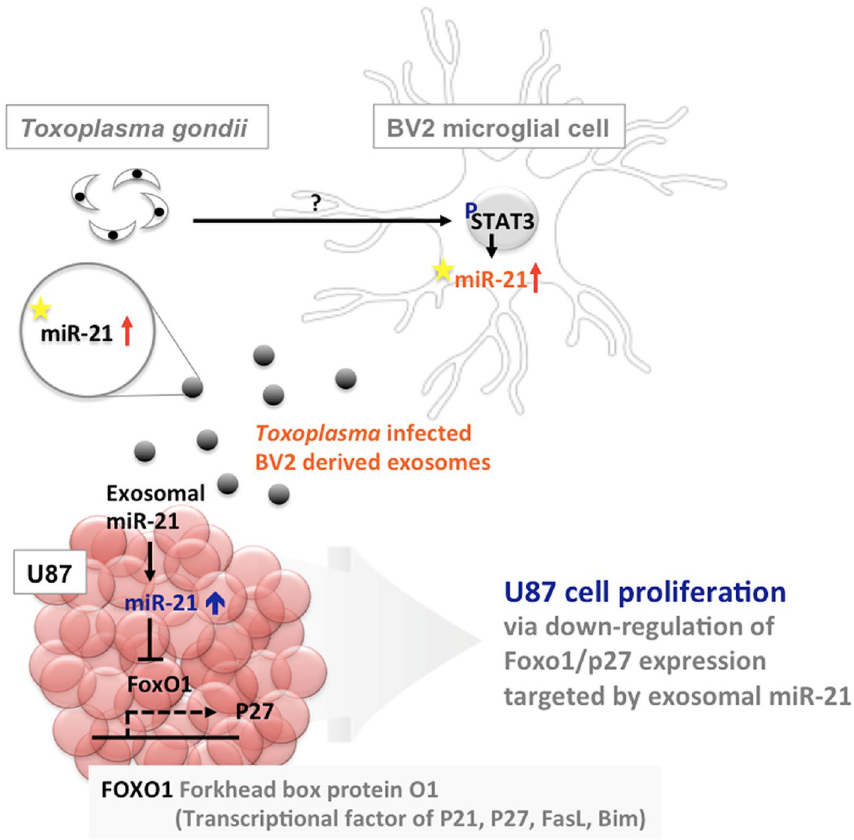
Figure 7. Schematic representation of carcinogenesis mechanisms of glioma (brain) suggested by the present study. Drawn by the authors using the PowerPoint 2019 version (Microsoft, Redmond,